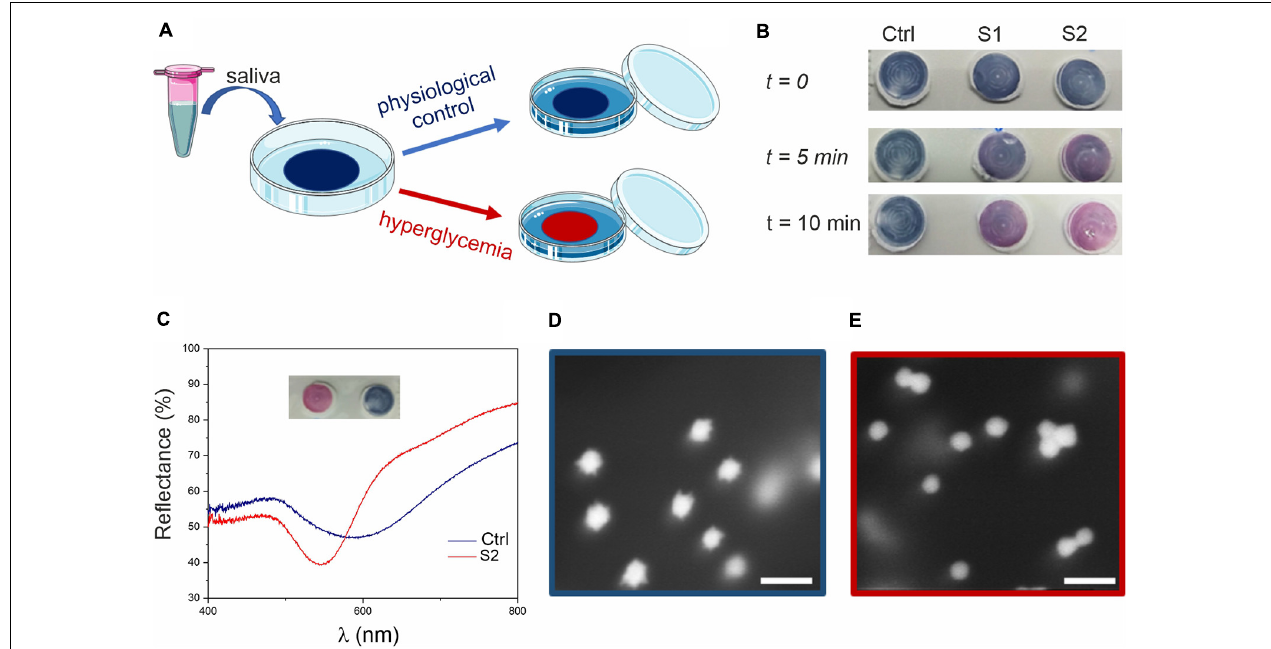
FIGURE 3 | Glucose colorimetric assay prototype for home-testing of saliva samples. (A) Schematics of the assay. The blue color of the membrane (due to the MGNPs on its surface) changes to pink/red if the saliva sample presents hyperglycemic conditions. (B) Colorimetric assay applied to human saliva (ctrl) and to human saliva supplemented with glucose at the concentration of 15 mg/dL (0.8 mM, S1) and 30 mg/dL (1.6 mM, S2). (C) Reflectance spectra of the membrane substrates, related to ctrl and S2 (picture in inset), showing a clear blue-shift (from λ = 600–550 nm). HR-SEM micrographs of (D) ctrl assay (blue) and (E) sample S2 (red) assay (scale bars: 100